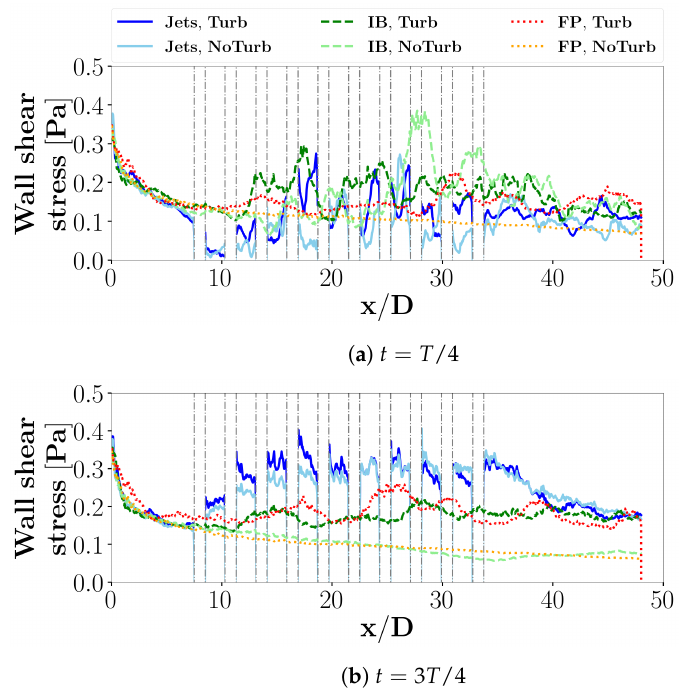
Figure 14. Phase-averaged wall shear stress along the perforated plate, with and without turbulence at inlet, for three axes: the symmetry line (jets), in between the jets (IB) and far from the jets (FP: “flat plate”). Lab